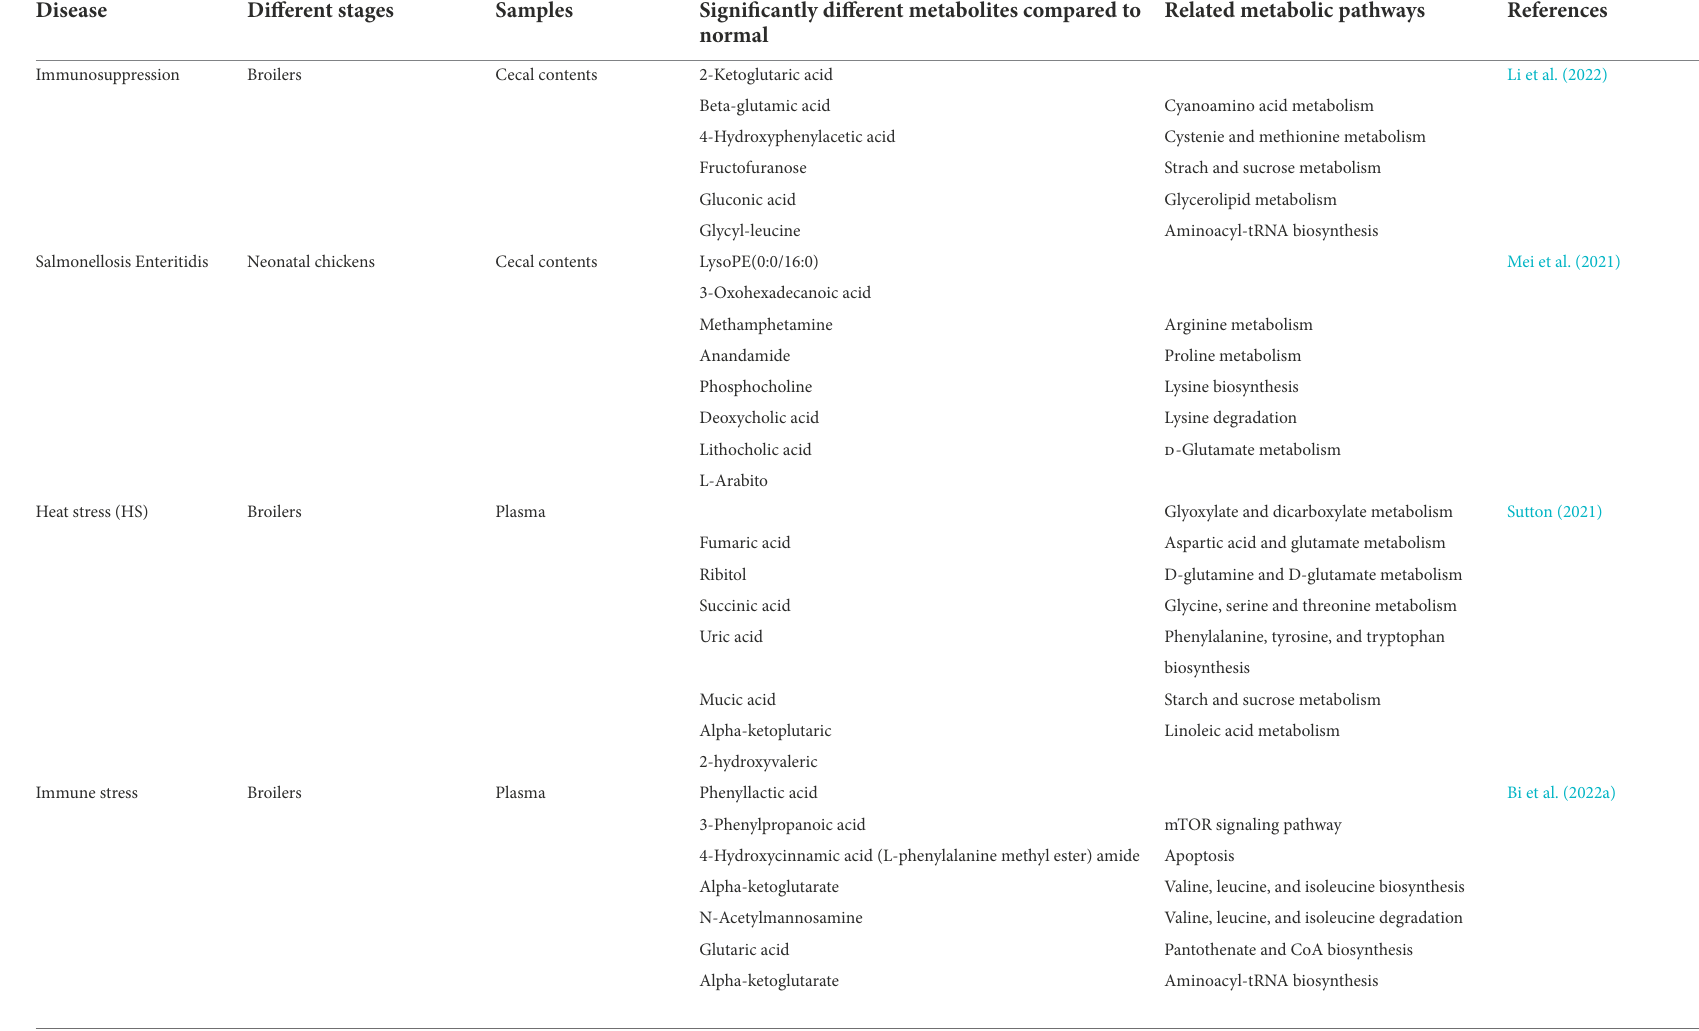
TABLE 3 Metabolome characteristics under